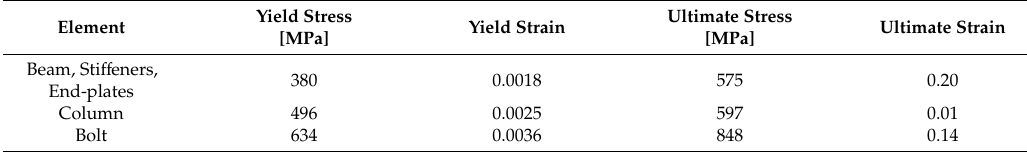
Table 3. Mechanical properties of test